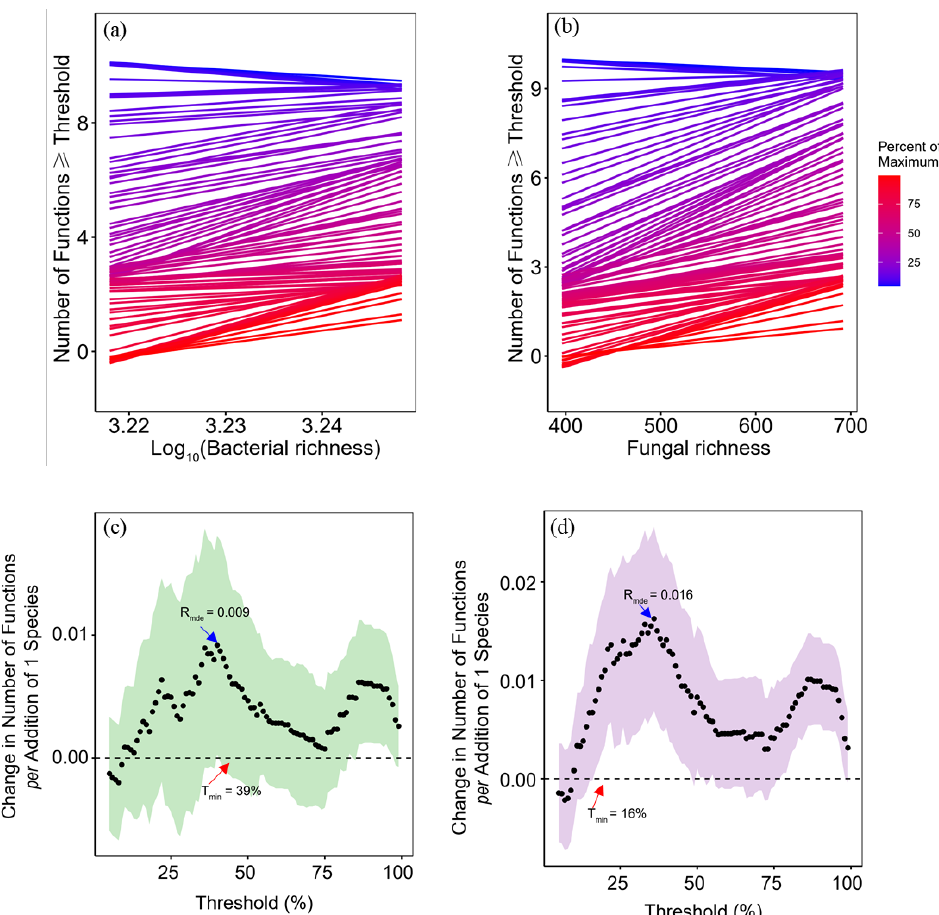
Figure 6. Effects of bacterial ( a ) and fungal ( b ) richness on the number of functions above thresholds. Lines represent the slope between soil microbial richness and the number of functions greater than or equal to a threshold value ranging from 5% to 99% of the maximum for each function. The dotted curves indicate the changes in the number of functions per unit increment of the richness of bacteria ( c ) and fungi ( d ). T min is the minimum threshold that soil multifunctionality becomes influenced by changes in microbial richness, and R med is the realized maximum effect of richness on soil multifunctionality.